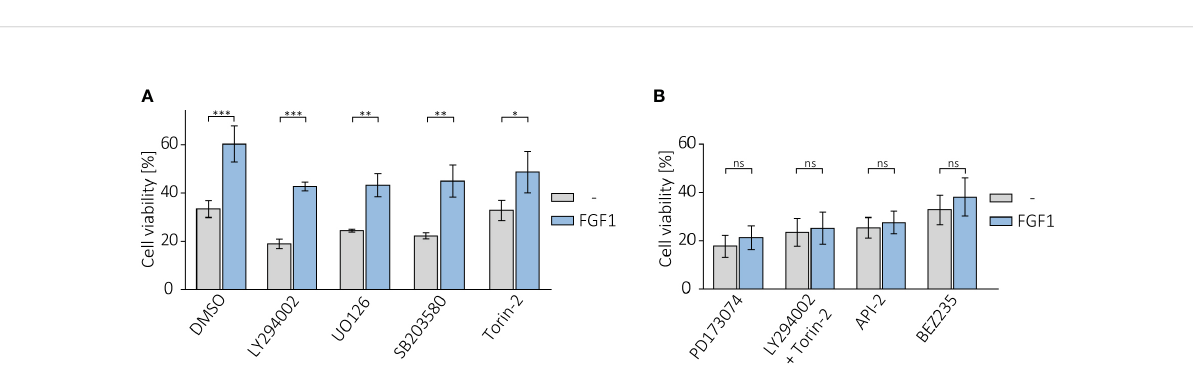
FIGURE 5 Effect of AKT inhibition on protective effect of FGF1 against TLT. Viability of U2OSR1 cells treated with 5 nM TLT and (A) different chemical inhibitors of major FGF-induced signaling pathways (20 µM LY294002 (PI3K), 20 µM UO126 (MEK1/2), 5 µM SB203580 (p38), 100 nM Torin-2 (mTOR)) or (B) FGFR inhibitor (100 nM PD173074), a direct AKT inhibitor (1 µM API-2), a dual mixture of PI3K and mTOR inhibitors (20 µM LY294002 + 100 nM Torin-2) or an inhibitor of both kinases, PI3K and mTOR (100 nM BEZ235) for 48 h in the presence or absence of 10 ng/mL FGF1, monitored by the alamarBlue assay. Results represent the mean ± SD of at least three independent experiments and are normalized to cells untreated with TLT; statistical signi fi cance: *p<0.05, **p<0.01, ***p<0.001, no signi fi cant differences are marked as ‘ ns ’